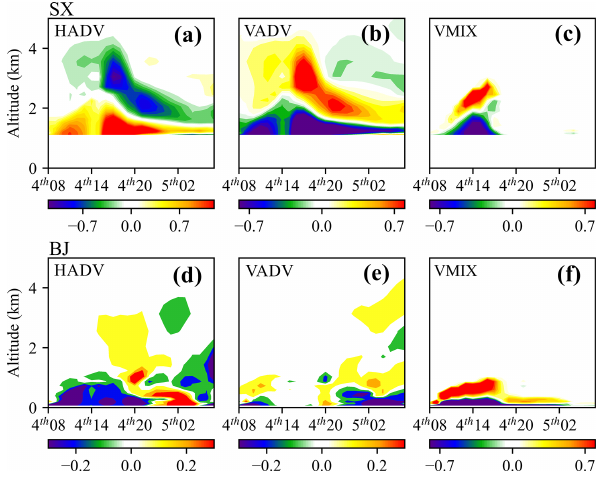
Figure 9. Contributions of horizontal advection (HADV), vertical advection (VADV), and vertical mixing (VMIX) processes to verti- cal BC concentrations in SX and BJ from 08:00BJT on 4 May to 08:00BJT on 5 May.